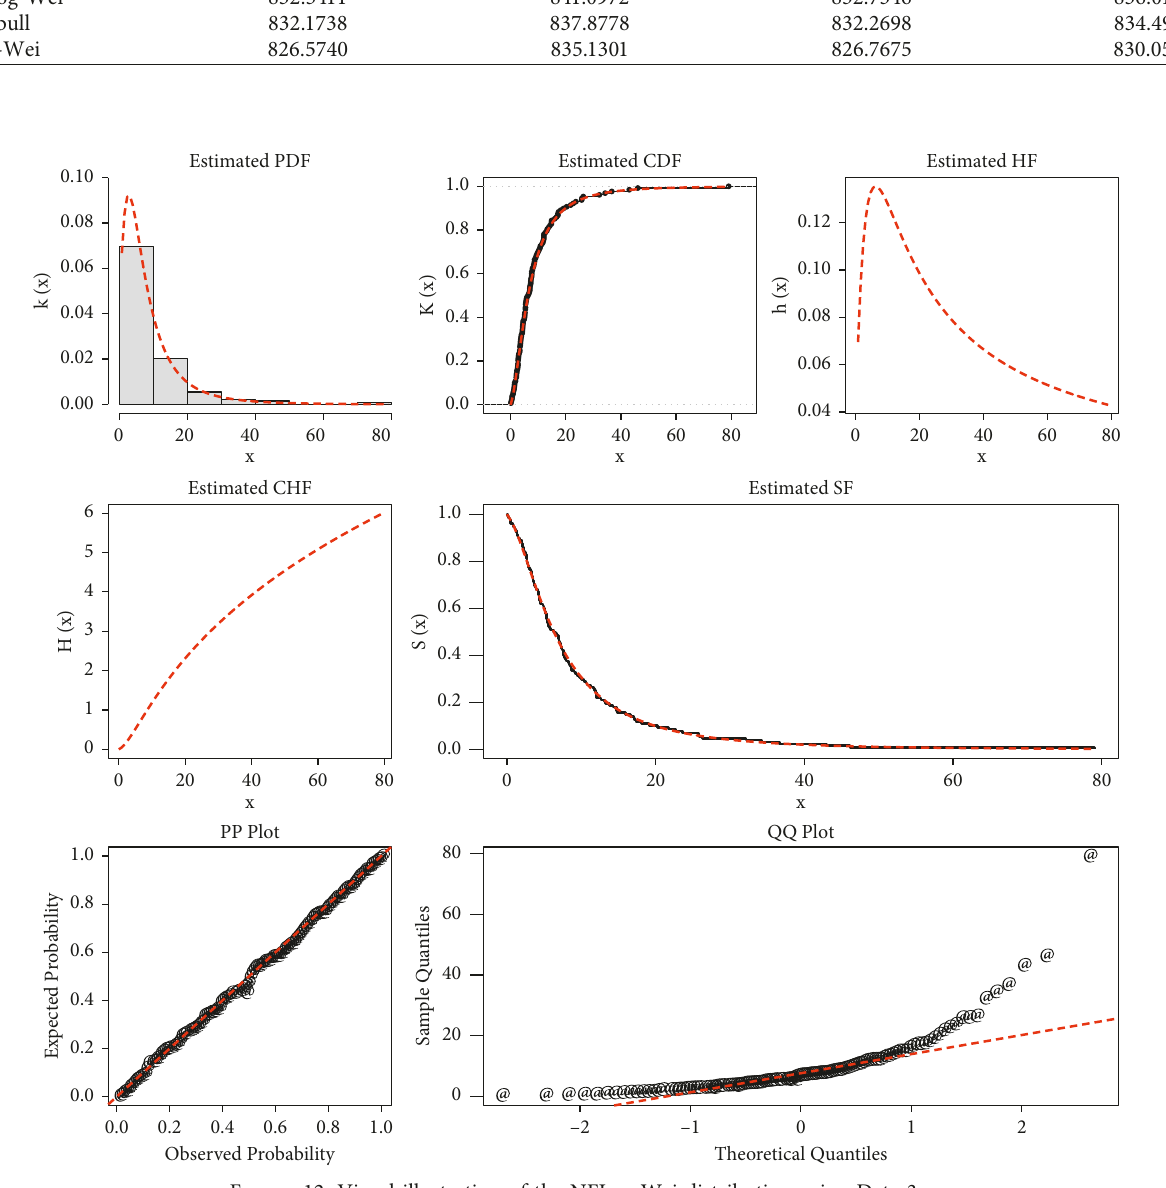
Figure 12: Visual illustration of the NFLog-Wei distribution using Data 3.